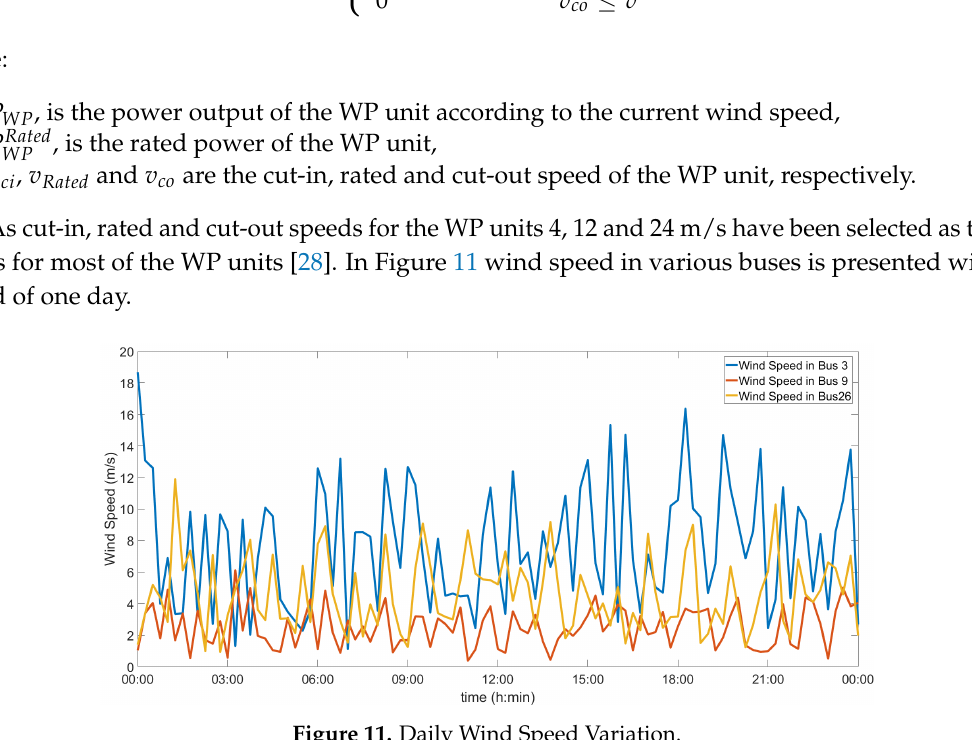
Figure 11. Daily Wind Speed